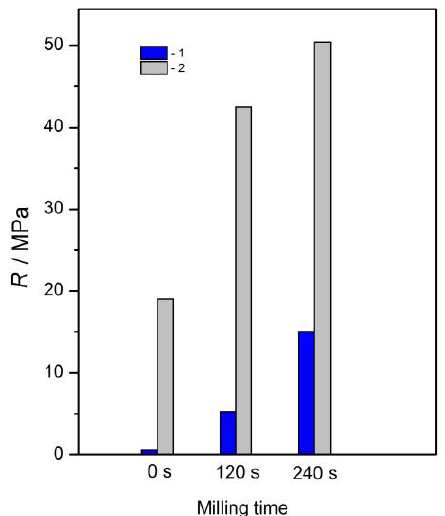
Figure 9. Compressive strength ( R ) of alkali-activated binders prepared using antigorite-containing ore dressing tailings (AT) milled in air in moderate conditions and liquid glass with a modulus of 3.18. The amount of liquid glass added corresponded to 4% Na 2 O. Curing time was 28 days. Hardening conditions were 1 : humid, or 2 : dry.